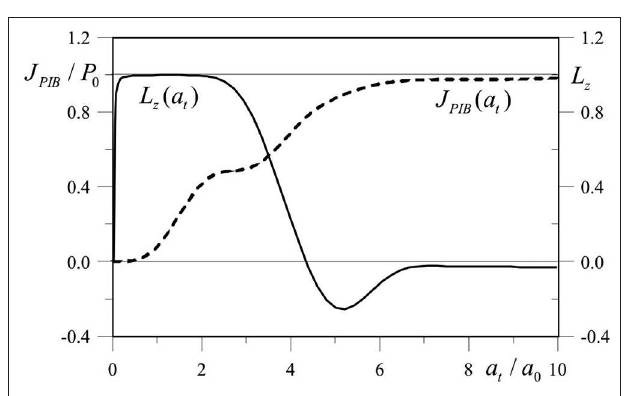
FIGURE 5 | Energy and OAM as functions of the radius of the receiving aperture. The parameters of the calculations are the same as in Figure 4